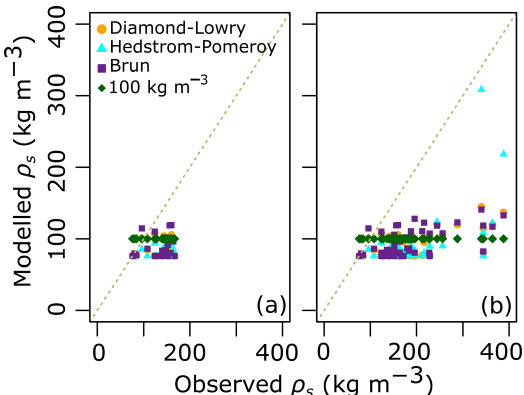
Figure 13. Top 10cm snow density derived from different empirical methods. (a) Observed versus modelled fresh-snow density ( < 24h since last snowfall); (b) observed versus modelled snow density in- cluding both fresh and snow density after metamorphism based on Eq.